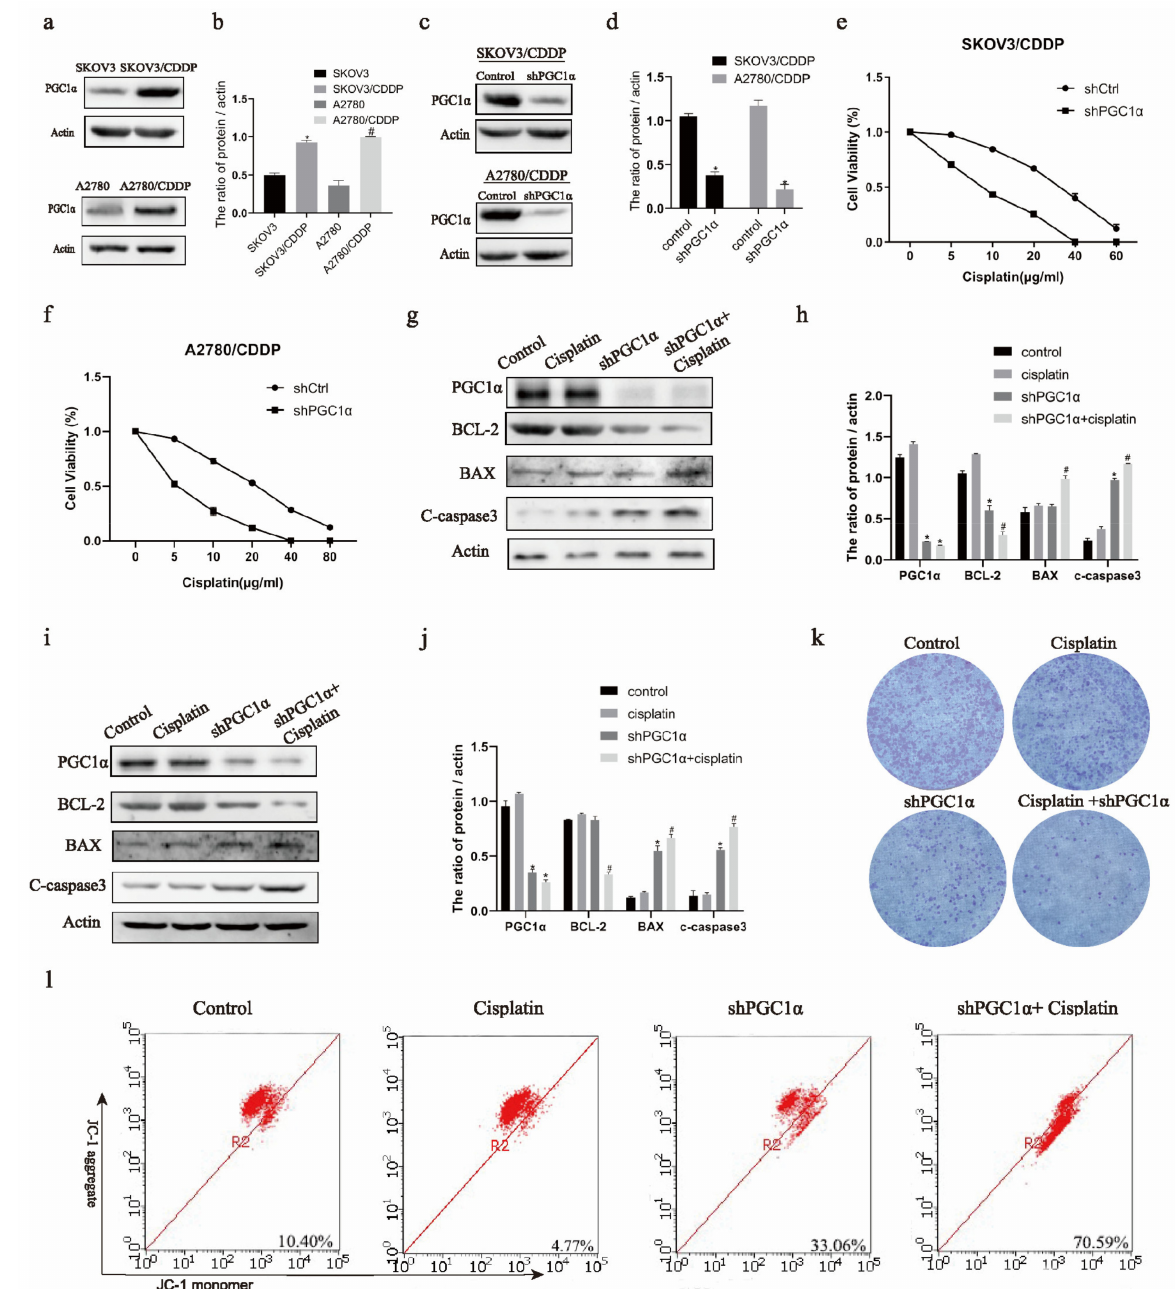
Figure 1. The knockdown of peroxisome proliferator-activated receptor coactivator 1 α (PGC1 α ) reversed cisplatin resistance in ovarian cancer. Western blot detected PGC1 α expression in SKOV3, A2780, SKOV3/CDDP, and A2780/CDDP cells ( a ). The PGC1 α protein/actin ratio is expressed as the mean ± SD; n = 3, * p < 0.05 vs. SKOV3, # p < 0.05 vs. A2780 ( b ). The level of PGC1 α protein decreased after Western blot detection of shPGC1 α ( c ). The protein/actin ratio is expressed as the mean ± SD; n = 3, * p < 0.05 vs. control ( d ). An MTT assay was used to detect the sensitivity of SKOV3/CDDP ( e ) and A2780/CDDP ( f ) cells to cisplatin with the knockdown of PGC1 α and expressed as the mean ± SD; n = 3. SKOV3/CDDP cells had high cell viability, and the half maximal inhibitoryconcentration (IC 50) was approximately 30 µ g/mL, but the IC 50 after knocking down PGC1 α was approximately 5 µ g/mL. The A2780/CDDP cells had high cell viability, and the IC 50 was approximately 22 µ g/mL, but the IC 50 after knocking down PGC1 α was approximately 4 µ g/mL. Western blot was used to detect B-cell lymphoma-2 (BCL2), BCL2-Associated X (BAX), and cleaved caspase 3 protein expression in SKOV3/CDDP and A2780/CDDP cells ( g , i ). The protein/actin ratio is expressed as the mean ± SD; n = 3, * p < 0.05 vs. control and # p < 0.05 vs. cisplatin ( h , j ). Clone formation was used to detect the proliferation ability of SKOV3/CDDP cells and is expressed as the mean ± SD; n = 3 ( k ). JC-1 was used to detect the mitochondrial membrane potential of SKOV3/CDDP and A2780/CDDP cells and expressed as the mean ± SD; n = 3 ( l